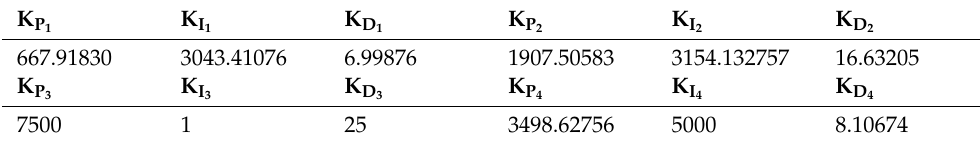
Table 7. The values of PID controllers’ parameters optimized by Optimizer -1.